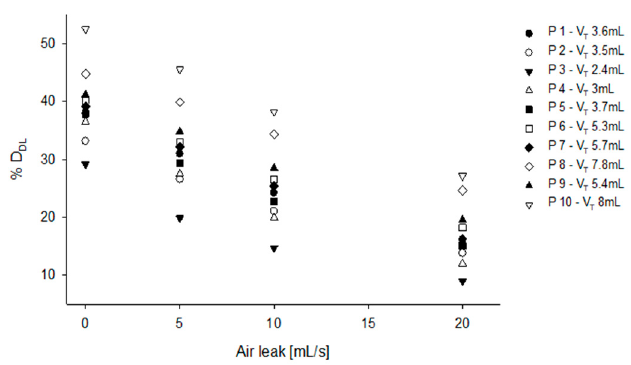
Figure 7. %D DL obtained feeding the model with real breathing signals recorded on neonatal patients, varying the leak associated to each test.